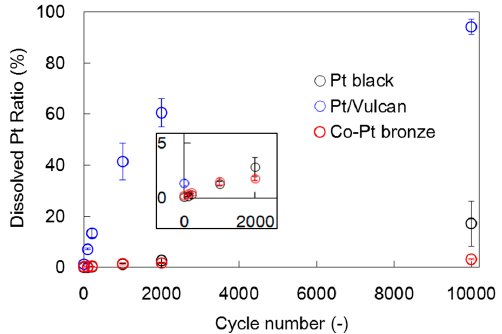
Figure 15. Pt dissolution ratio (=dissolved Pt/load Pt on glassy carbon) during potential cycle accelerated durability test. Inserted is an expansion.